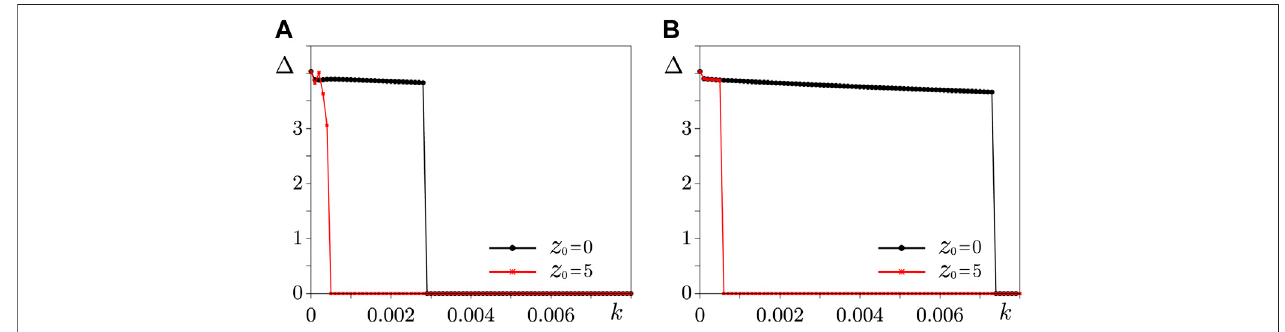
FIGURE 2 | Dependencies of the synchronization error Δ of traveling waves on the memristive coupling coef fi cient k in two identical rings σ 1 = σ 2 = 4.5 obtained for two different values of z 0 in the case of an ideal memristive coupling δ = 0 (A) and in the case of non-ideal memristors with the forgetting parameter δ = 0.1 (B) .